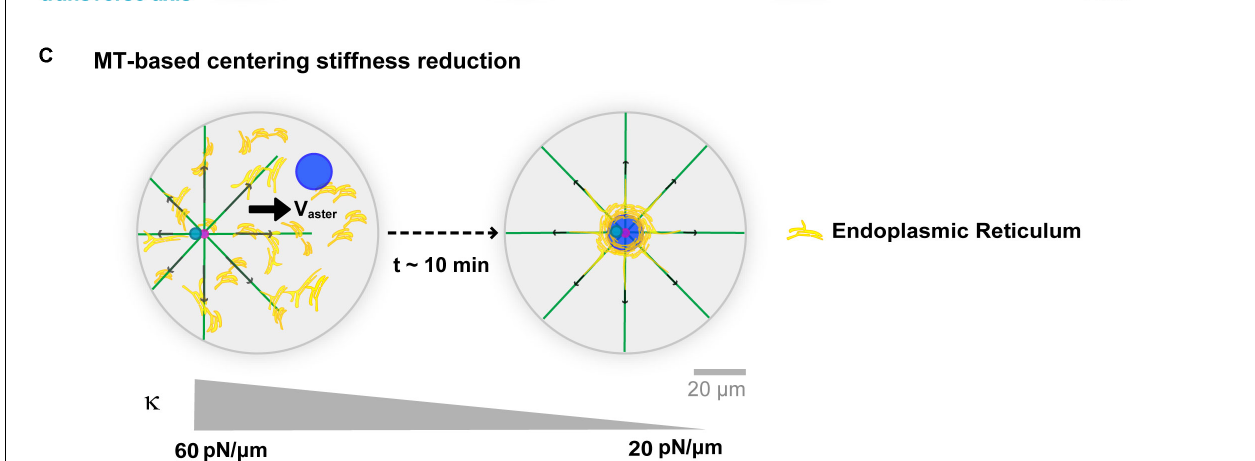
Frontiers in Cell and Developmental Biology |